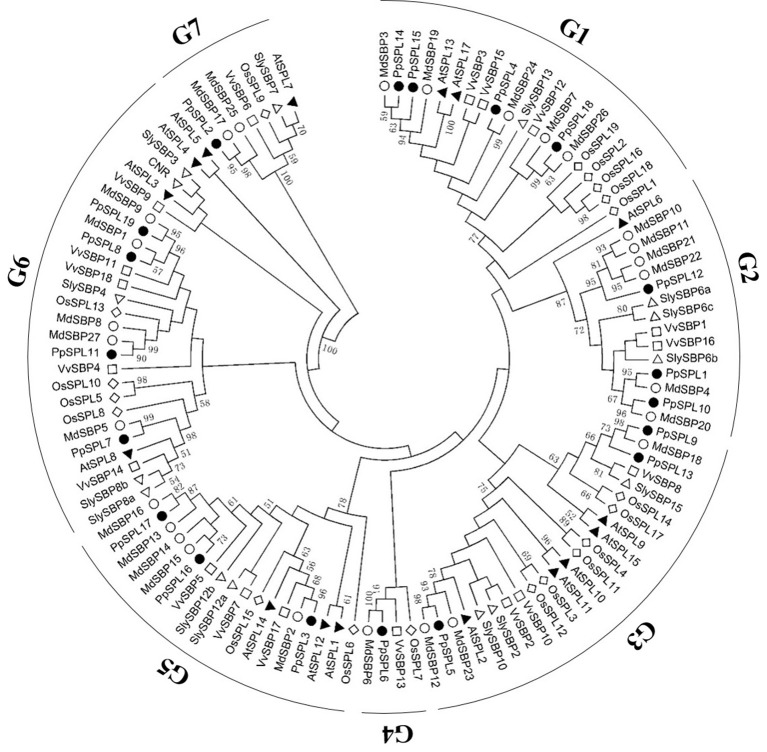
Phylogenetic analysis of SPLs from pear and other plant species. A phylogenetic tree was constructed using SBP domain protein sequences from pear (PpSPL, marked with black dots), apple (MdSBP, marked with white dots), grape (VvSBP, marked with white squares), rice (OsSPL, marked with white rhombuses), tomato (CNR or SlySBP, marked with white triangles), and Arabidopsis thaliana (AtSPL, marked with black triangles). The symbols for Arabidopsis thaliana and tomato genes are inverted in the right and left halves of the figure. PpSPL1, PpSPL4, PpSPL5, PpSPL6, PpSPL9, PpSPL10, PpSPL12, PpSPL13, PpSPL14, PpSPL15, and PpSPL18 are putative miR156 targets. The SBP domain sequences used to construct the phylogenetic tree as well as the accession numbers or locus IDs and data sources of the SBP-box genes from different species are listed in Supplementary Table S12 in Supplementary File 1.